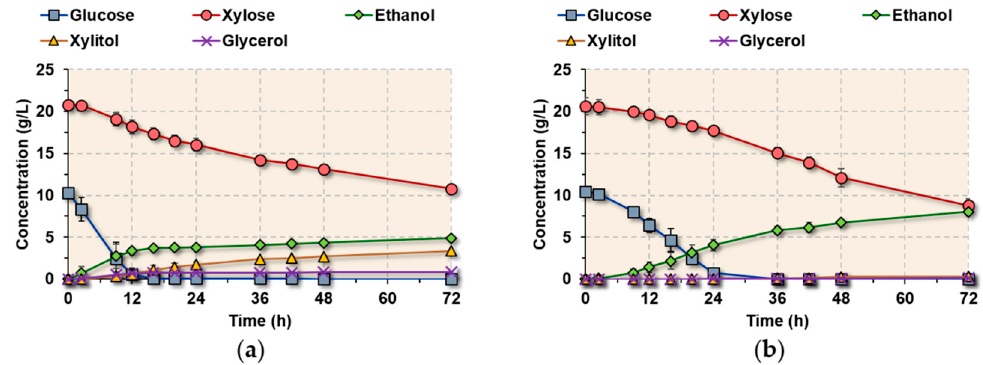
Figure 4. Time course of batch fermentation of synthetic medium. Assays were performed using ( a ) C. intermedia CBS 141442 and ( b ) S. stipitis CBS 6054 as fermentative microorganisms. No glucose or xylose was added during the fermentation process. Values were calculated from two independent cultivations and the error bars indicate the minimum and maximum values.